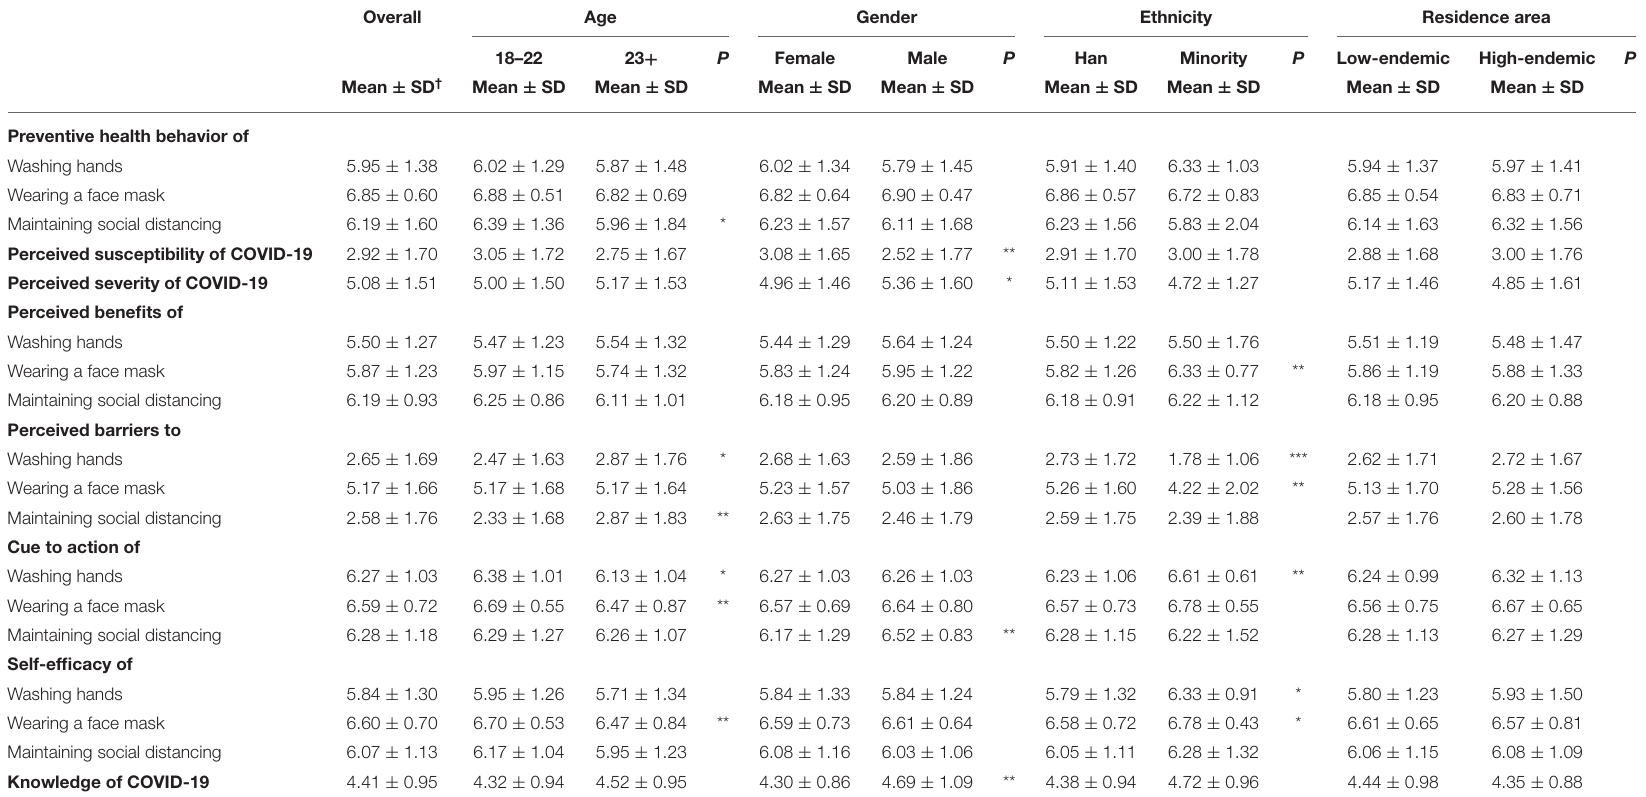
TABLE 2 | Preventive health behaviors of study respondents by age, gender, ethnicity, and residence